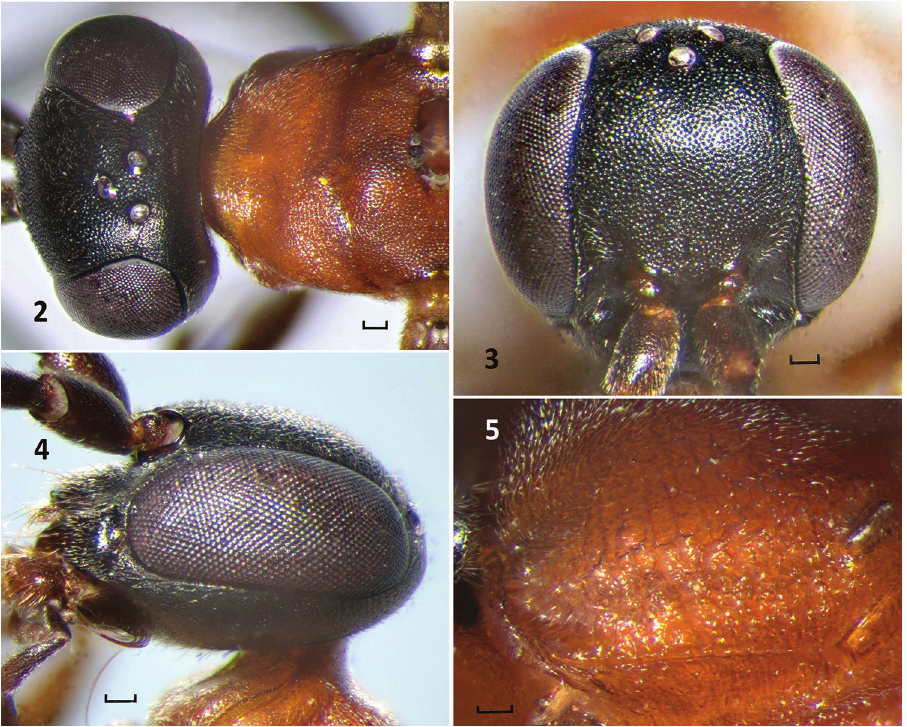
Figures 2–5. Nipponodipogon orientalis Loktionov, Lelej & Xu, sp. n., female, paratype. 2 Head and pronotum, dorsal view 3 Head, frontal view 4 Head, lateral view 5 Propodeum, dorsolateral view. Scale bars 0.1